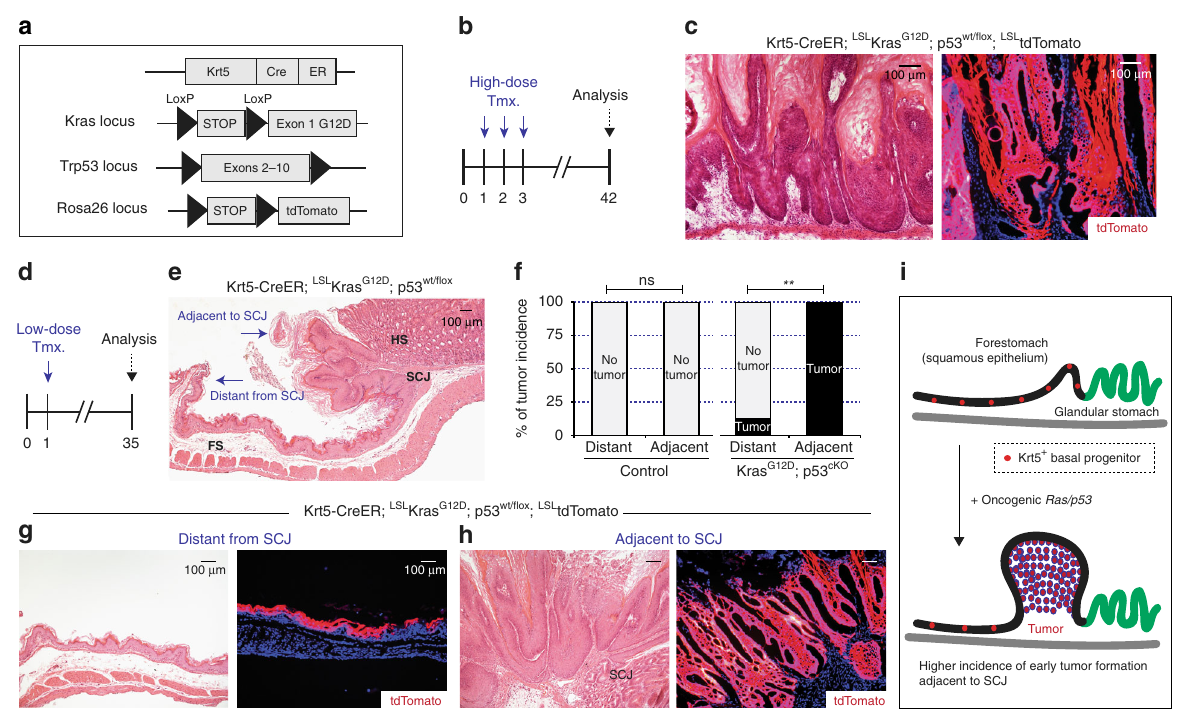
Fig. 1 Higher susceptibility of tumor initiation from Keratin5 + (Krt5 + ) progenitors near the SCJ. a , b Experimental scheme. c Oncogenic Ras/p53-mediated tumor formation throughout the forestomach tissues. d Experimental scheme. e , f Histological phenotype of early tumor initiation and higher tumor incidence from tumor-prone Krt5 + progenitors resident at regions adjacent to the SCJ ( n = 8 animals per each). Statistical signi fi cance was determined by Fisher ’ s exact test; ns = not signi fi cant, ** p < 0.005. g , h Histological phenotype of early tumor initiation and tdTomato lineage tracing. i Summary of early tumor formation from tumor-prone Krt5 + basal progenitors expressing oncogenic Ras/p53 combination. FS, forestomach; HS, hindstomach; SCJ, squamocolumnar junction; Tmx, tamoxifen. Scale bars, 100 µ